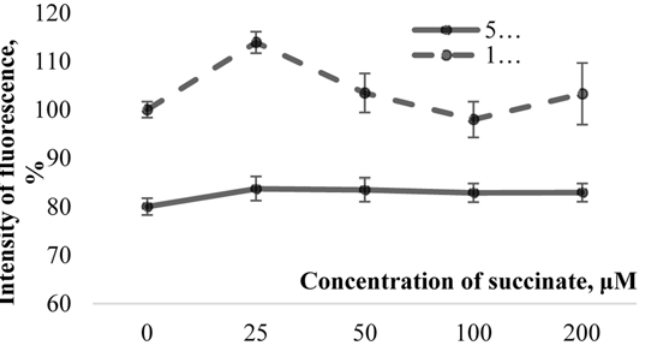
Figure 3. Influence of the medium with different deuterium content on the value of mitochondrial membrane potential in cultured neurons of the rat cerebellum. Note: on the Y-axis, the intensity of the fluorescence as a percentage is shown. Data are presented as M ± m as a percentage of 150 ppm at a 0 μM concentration of succinate.